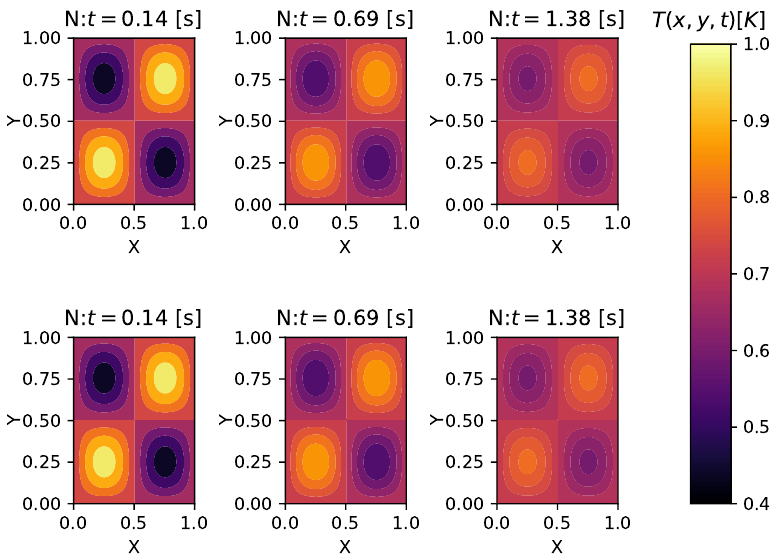
Figure A9. Verification of heat diffusion equation by comparing the analytical and numerical